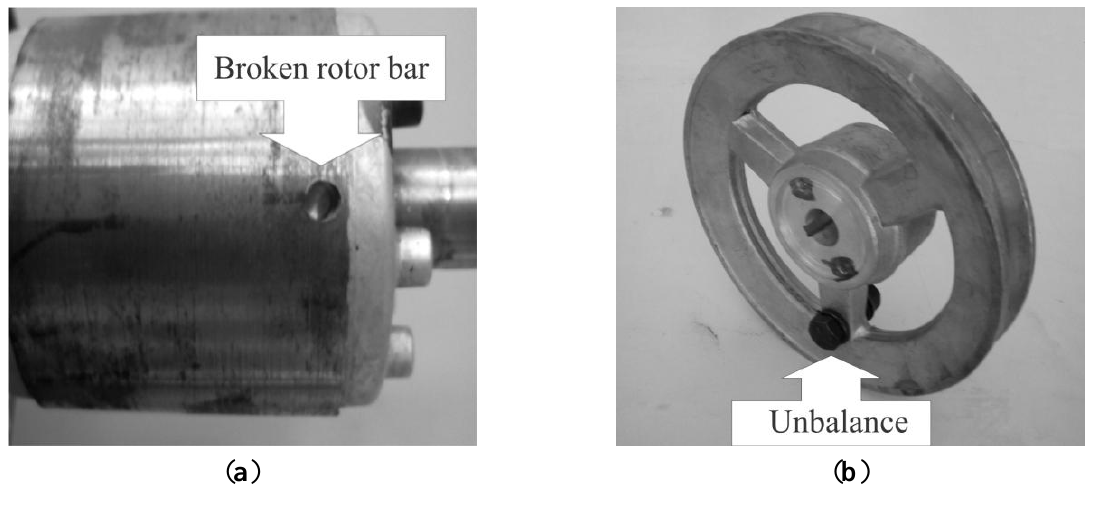
Figure 10. ( a ) Motor aligned; ( b ) Motor misaligned.